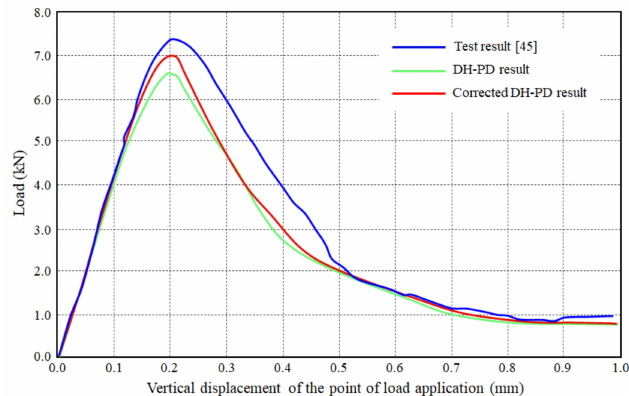
Figure 17. Comparison of the numerical and experimental displacement–load curves [45].